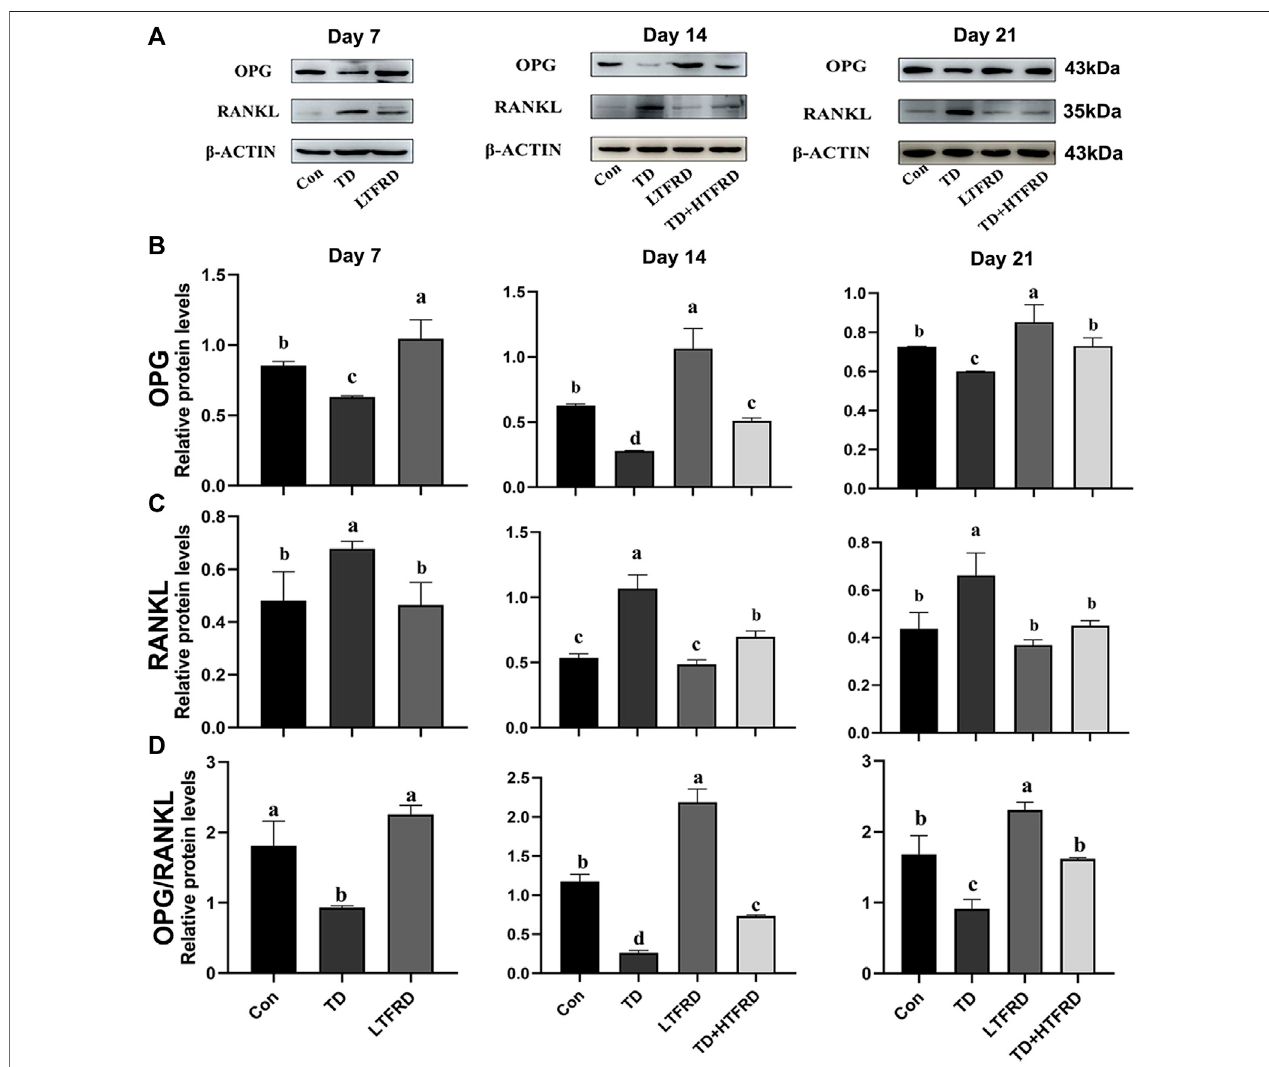
FIGURE 5 | Effects of LTFRD on OPG/RANKL protein level of tibial growth plate in TD broilers. (A) The gray scale analysis of OPG, RANKL and β -ACTIN. (B) The protein level ofOPG. (C) The protein level of RANKL. (D) The protein level of OPG/RANKL The results are represented asmean ± SD. a, b, c, and d represent signi fi cant differences between groups ( p <